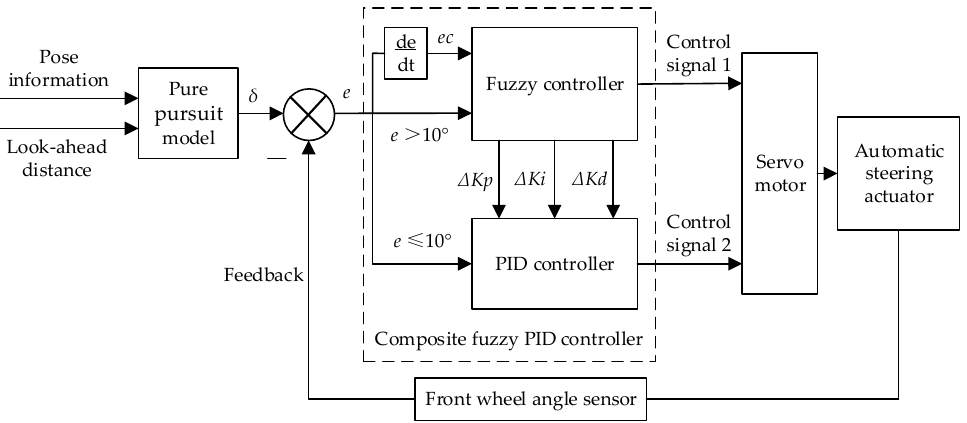
Figure 4. Principle diagram of compound fuzzy proportional-integral-derivative (PID) controller.